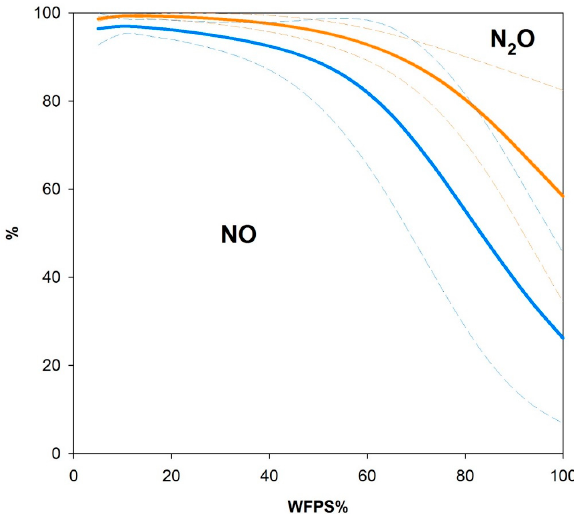
Figure 6. Partitioning of gaseous N loss between NO and N 2 O over WFPS in HS and GDZ soils, expressed as mole N percent of NO in total reactive N gas release (N 2 O + NO). Shown are mean values (bold solid lines) and standard deviations (fine dashed lines) for HS soils (blue line, n = 4) and for GDZ soils (yellow line, n = 2).